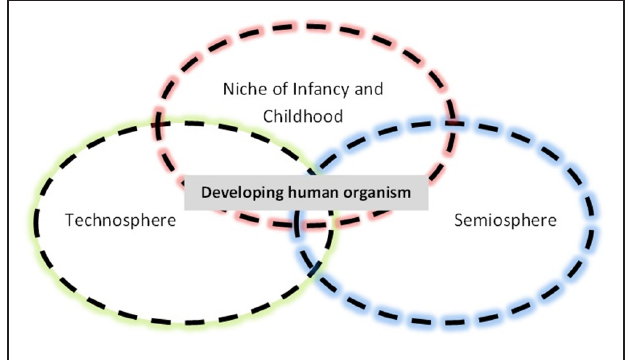
FIGURE 3 | Niche-organism-niche co-evolution of the human biocultural complex. Figure © Chris Sinha.